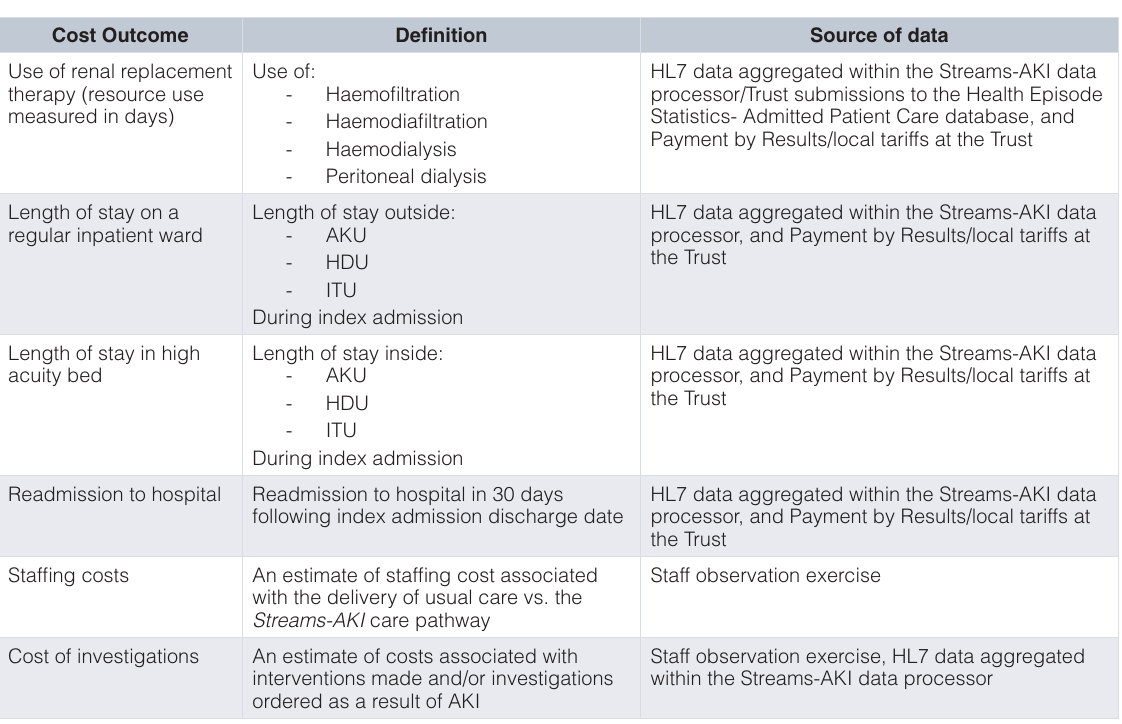
Figure 1 outlines the timeframes for each phase of the service evaluation, as described